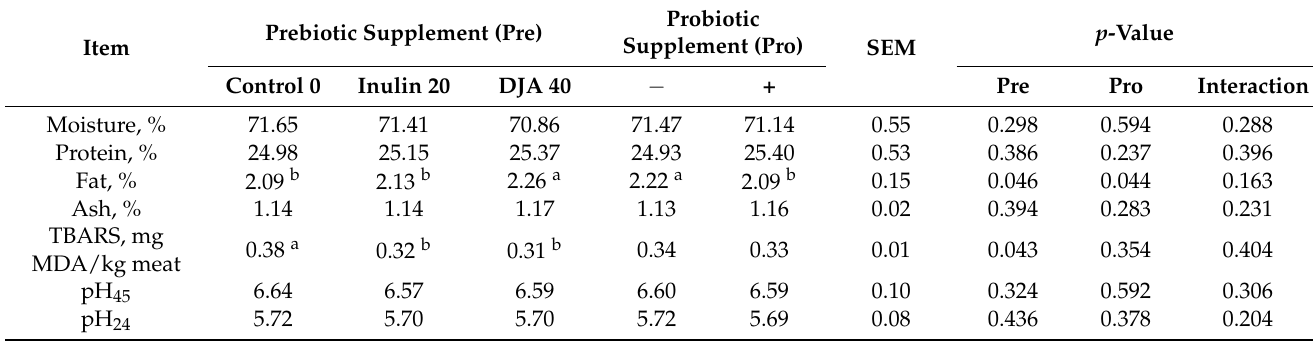
Table 4. Proximal composition, TBARS, and pH of meat (m. longissimus